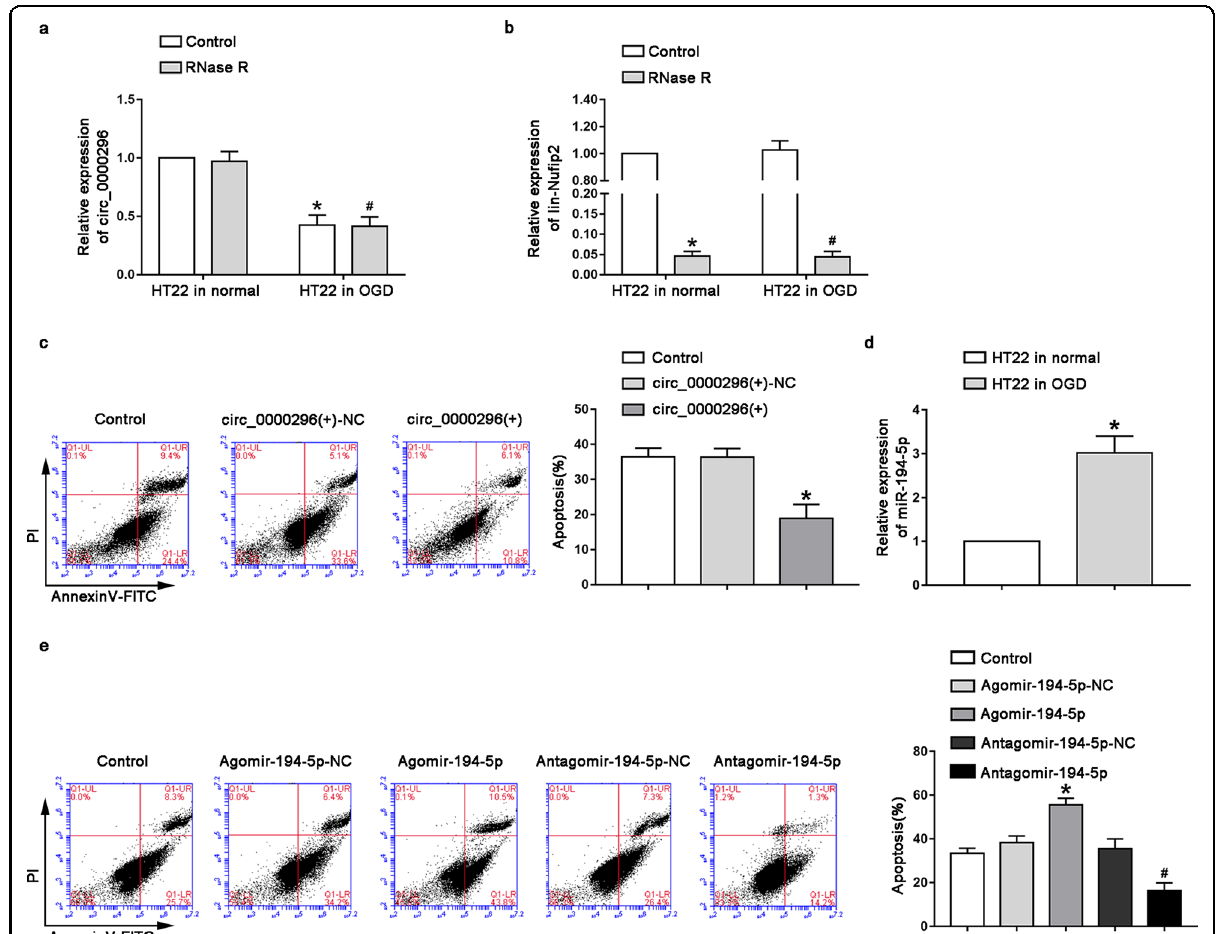
Fig. 1 Effect of CCI to neuronal apoptosis and relative expression levels of circ_0000296 and miR-194-5p. a Relative expression of circ_0000296 in OGD-induced HT22 cells and HT22 cells in normal with RNase R treatment by quantitative real-time PCR. Data represented as mean ± SD. ( n = 5), * P < 0.05 vs. normal HT22 cells with control group. # P < 0.05 vs. normal HT22 cells group with RNase R treatment. b Relative expression of lin-Nu fi p2 in OGD-induced HT22 cells and HT22 cells in normal with RNase R treatment. Data represented as mean ± SD ( n = 5). * P < 0.05 or # P < 0.05 vs. control group. c Flow cytometry analysis of OGD-induced HT22 cells with overexpression of circ_0000296 with annexin V/PI staining. Data represented as mean±SD ( n = 3). * P < 0.05 vs. circ_0000296( + )-NC group. d Relative expression of miR-194-5p in OGD-induced HT22 cells and HT22 cells in normal by quantitative real-time PCR. Data represented as mean±SD ( n = 5). * P < 0.05 vs. OGD-induced HT22 cells control group. e Flow cytometry analysis of OGD-induced HT22 cells with transfection of miR-194-5p with annexin V/PI staining. Data represented as mean ± SD ( n = 3). * P < 0.05 vs. Agomir-194-5p-NC group, # P < 0.05 vs. Antagomir-194-5p-NC